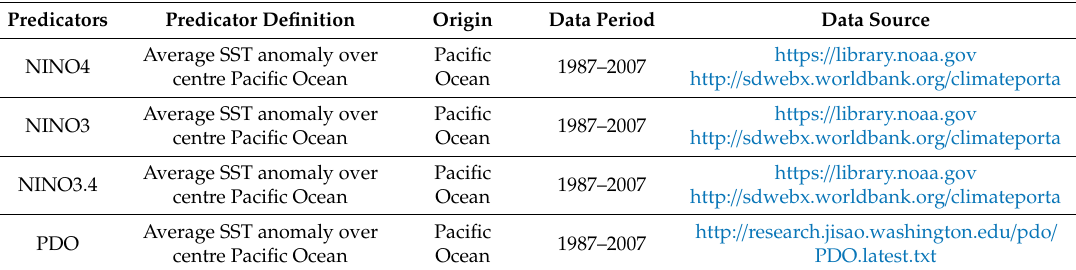
Table 1. Detail of used climate indexes for the